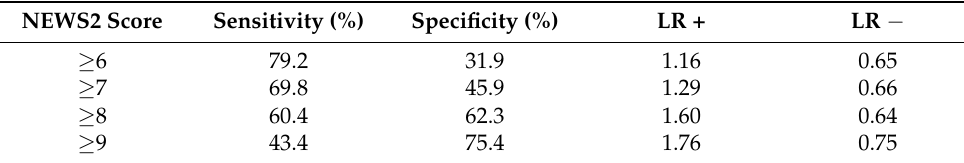
Table 3. Sensitivity of NEWS2 at Initial Admission to Predict Early Progression of Pneumonia.